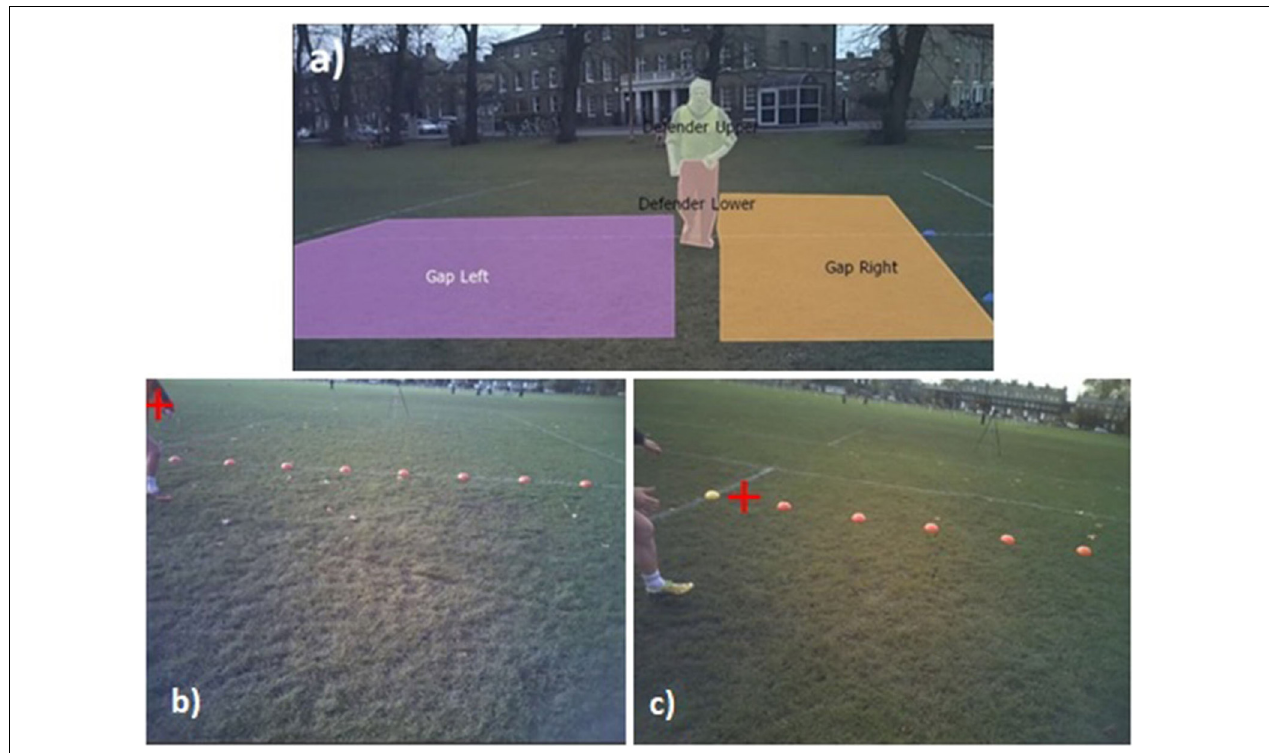
FIGURE 2 | (a) Coding window used to track AOIs Gap Left, Gap Right, Defender (upper and lower). Illustration of fixation on (b) Support Player (c) Fixation Ahead Support